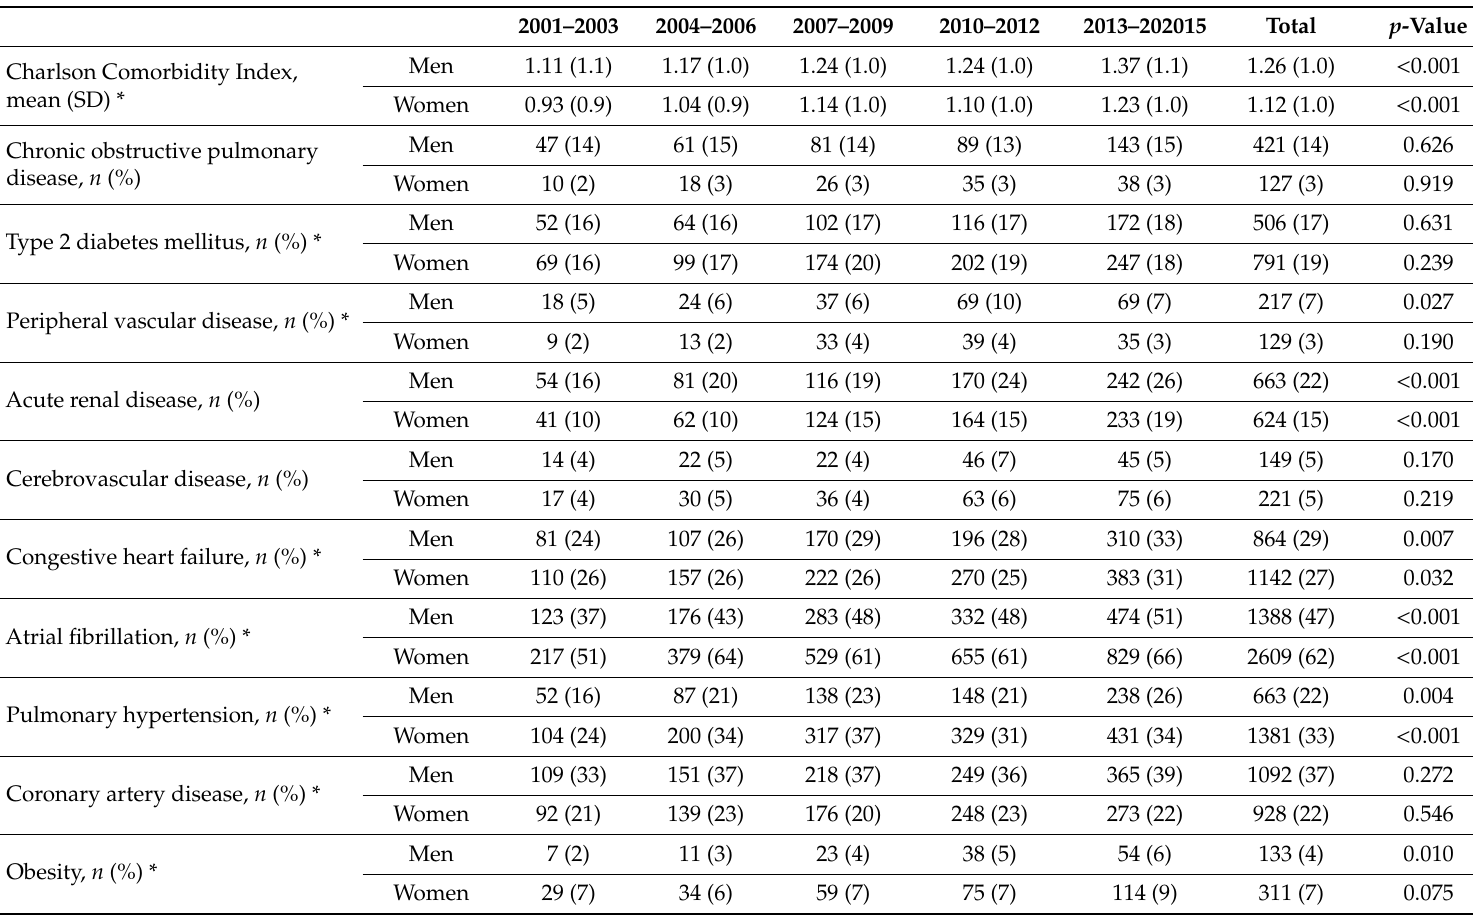
Table 3. Comorbidity of patients hospitalized that underwent a bioprosthetic mitral valve replacement in Spain from 2001 to